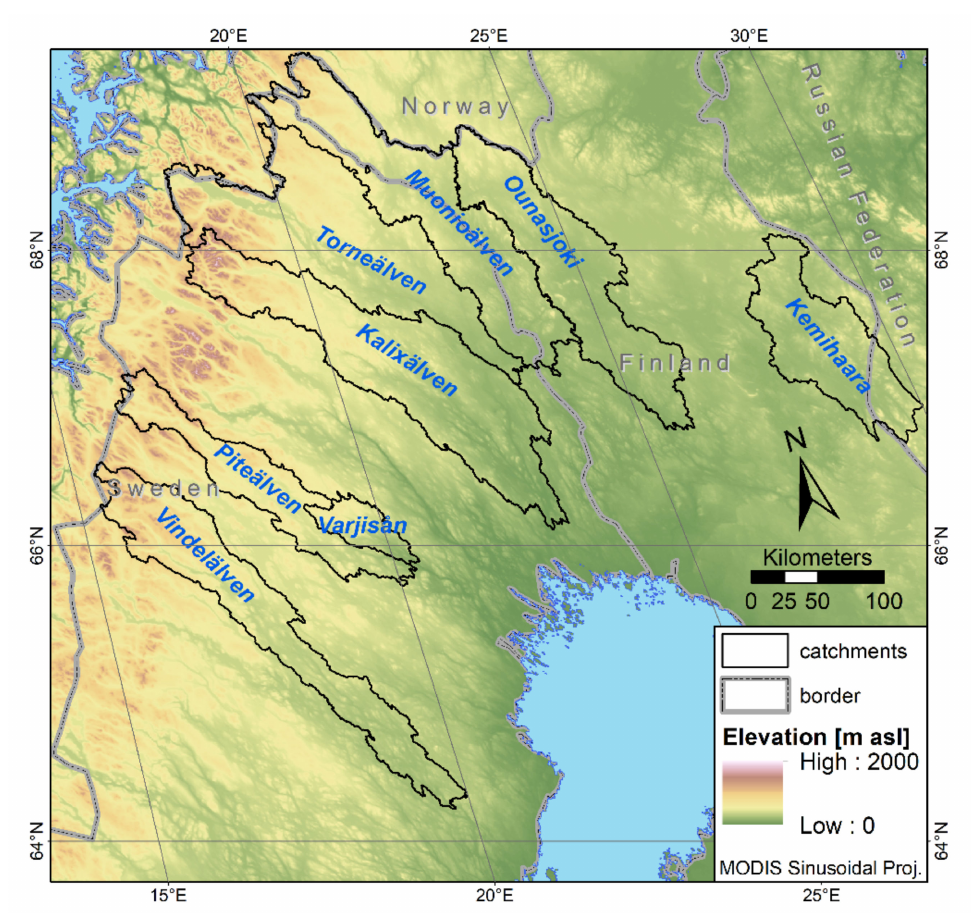
Figure 2. Main study area of S á pmi showing the location of the eight selected catchments.